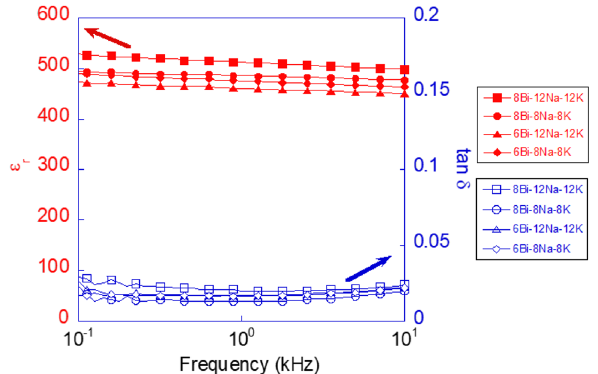
Fig. 7 Dielectric constant (ε ) and dielectric loss (tan δ ) vs. fre- r quency for 210 nm thin films crystallized at 700 °C for 5 min with varying excess amounts: 6% Bi excess and 8% Na and K excess ( 6Bi- 8Na-8 K ), 6% Bi excess and 12% Na and K excess ( 6Bi-12Na-12 K ), 8% Bi excess and 8% Na and K excess ( 8Bi-8Na-8 K ), and 8% Bi excess and 12% Na and K excess ( 8Bi-12Na-12 K